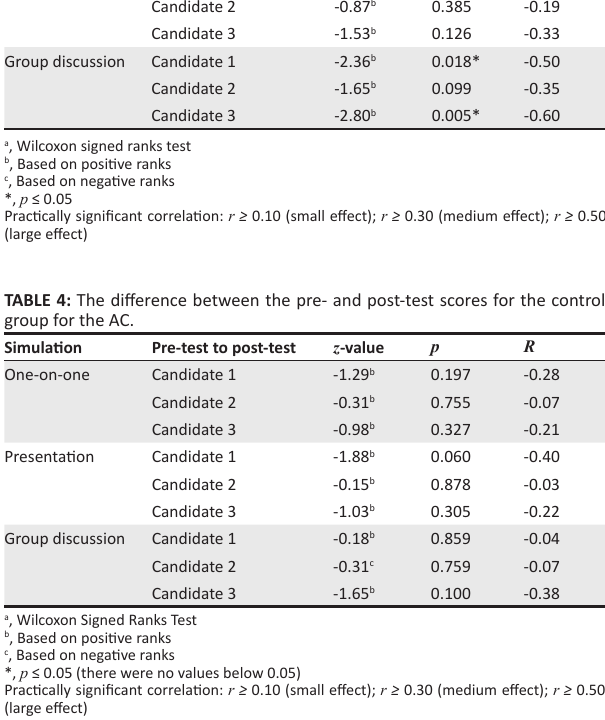
TABLE 3: The difference between the pre- and post-test scores for the experimental group for the AC. Simulation